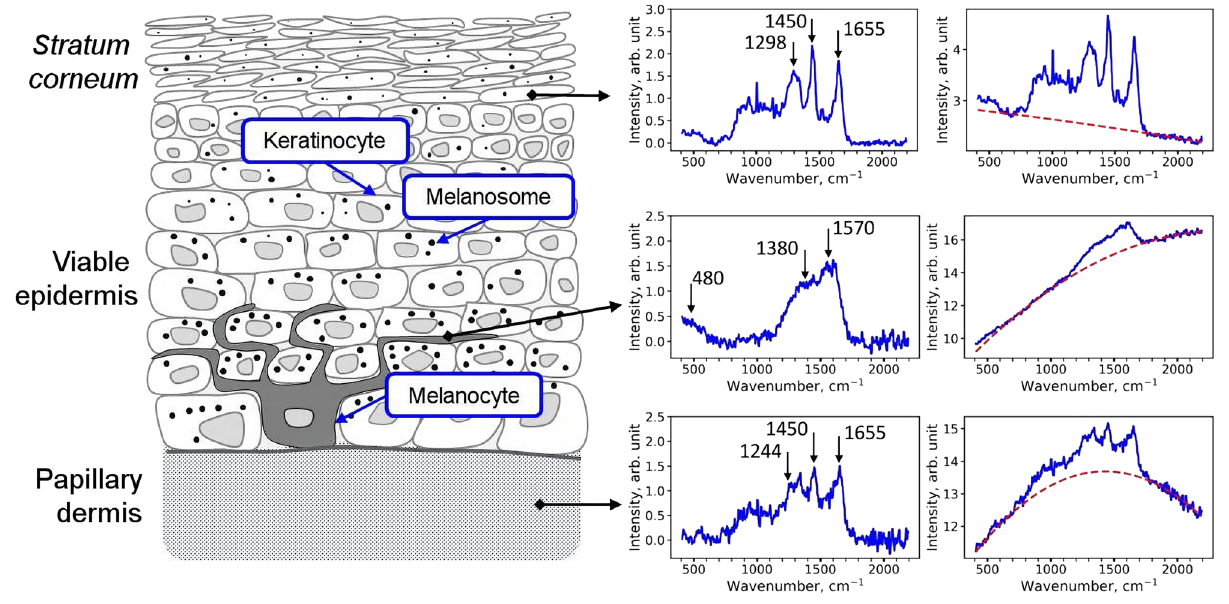
Figure 6. Schematic representation of the skin structure with an indication of typical Raman and fluorescence spectra corresponding to different